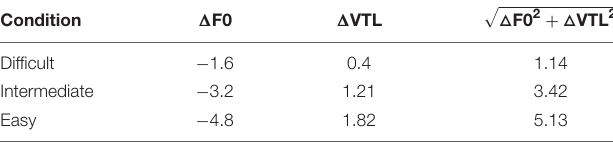
TABLE 1 | Distance between the target and the masker voices, in semitones.